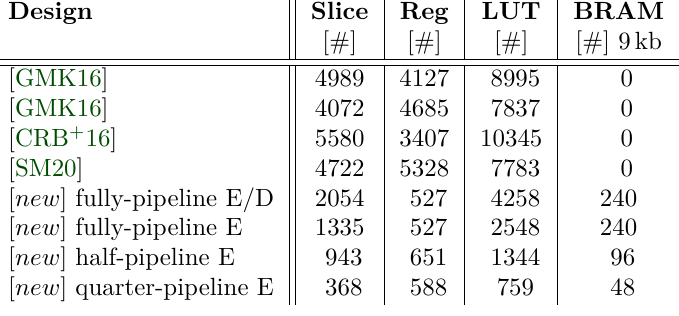
Table 2: Comparison of high-performance implementations including PRNG (with key masking, mapped on Xilinx